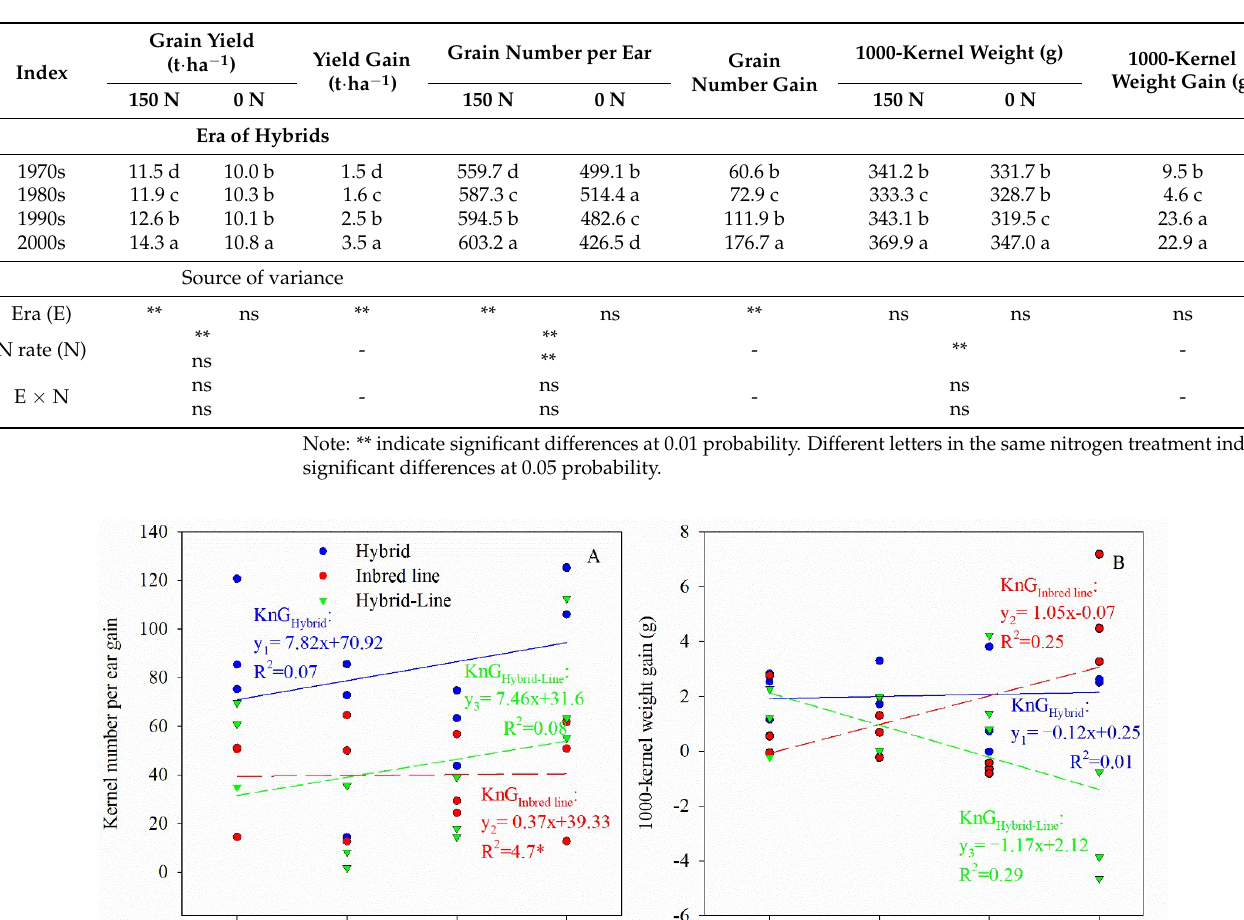
Table 2. Effect of N applications on yield and yield components of hybrids.